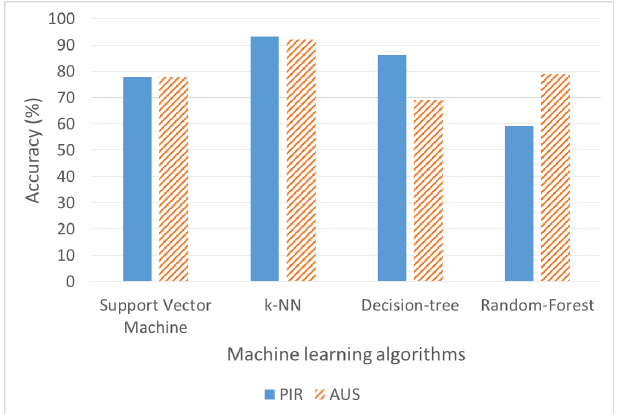
Figure 7. Accuracy of different ML algorithms for both AUS and PIR sensor mounted on a mobile